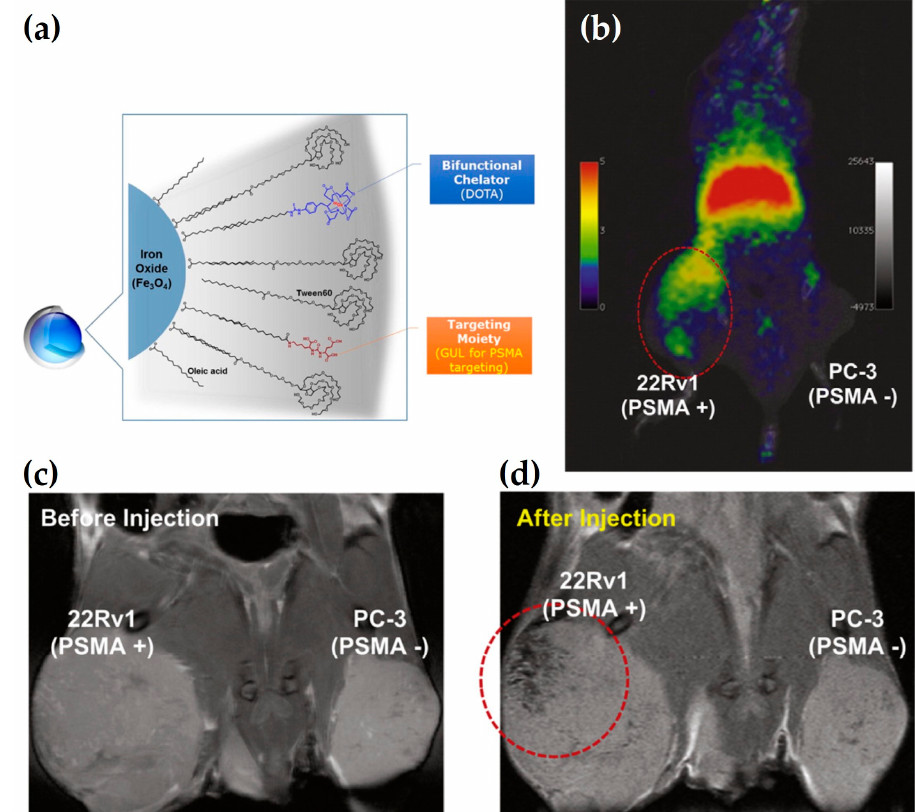
Figure 10. ( a ) The IONs have been radiolabeled with 68 Ga via the use of DOTA chelator and are conjugated with the targeting ligand, glutamate-urea-lysine (GUL), to selectively target the prostate for PET/MRI dual imaging; ( b ) Representative PET imaging data obtained after 1 h injection of 68 Ga-DOTA-IONs-GUL DMCA in a BALB/c mouse with PSMA-positive and negative cell lines; Representative T 2 -weighted MR images ( c ) before and ( d ) after 1 h injection of DOTA-IONs-GUL in a BALB/c mouse with PSMA-positive and negative cell lines. The red dotted circles indicate the selective uptake of ( b ) 68 Ga-DOTA-IONs-GUL and ( d ) DOTA-IONs-GUL, respectively, to the 22Rv1 positive tumor (Reprinted from [72], with permission from Elsevier).